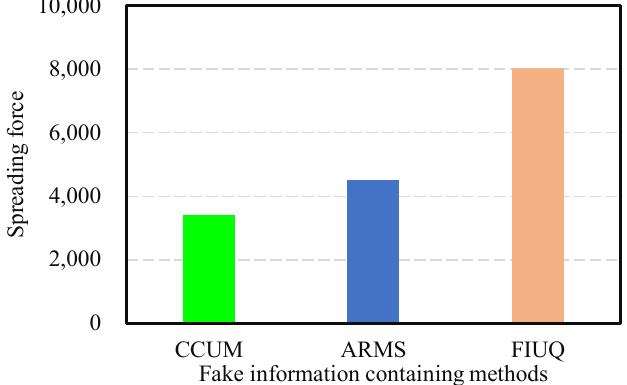
Figure 5. Spreading force of the different methods.